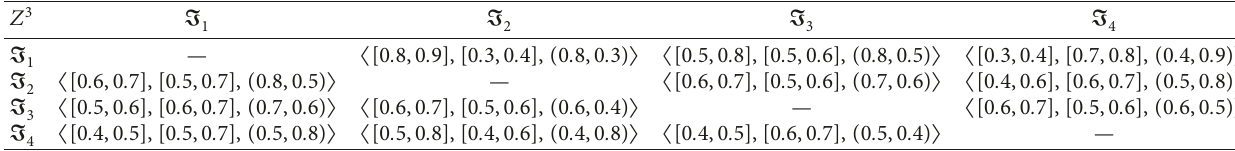
Table 3: CuPFPR with respect to the criteria “professional